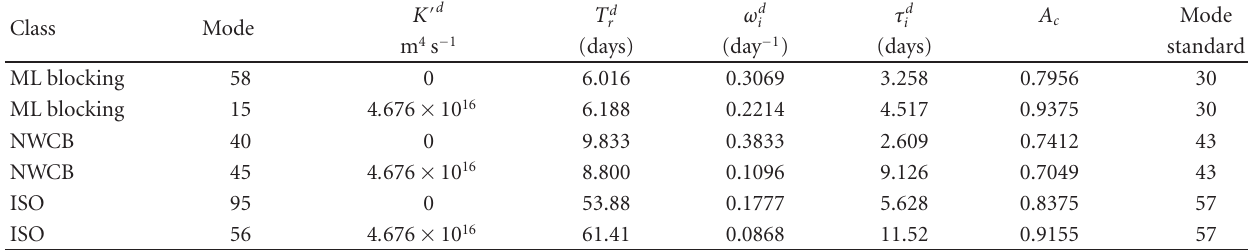
= 1500K and C d = 5 × 10 − 4 Km − 1 F F